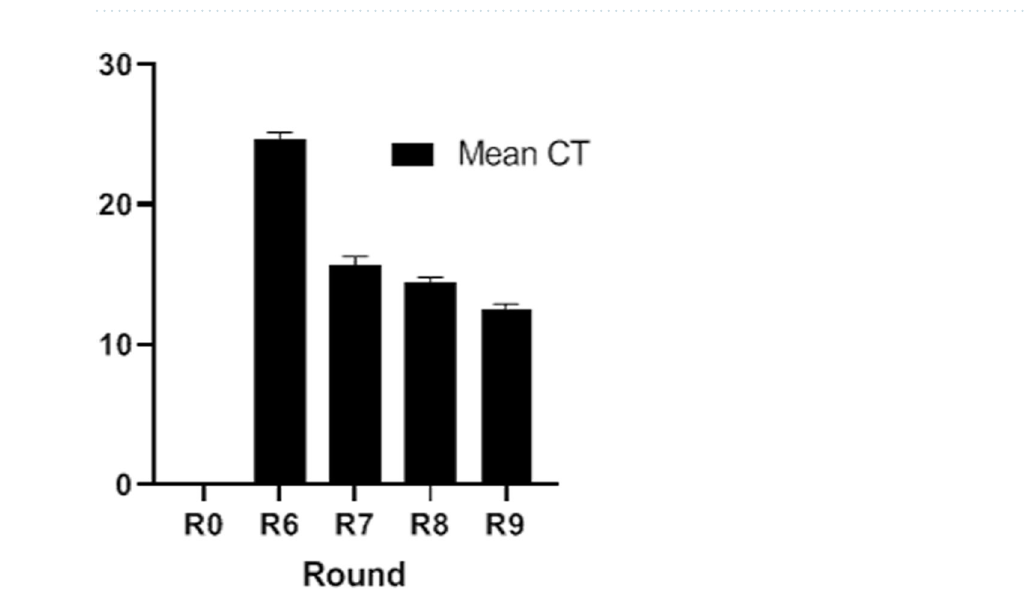
Figure 1. Schematic display of SELEX steps. ( A ) Schematic display of the preparation CCHFV NP-MB. The C-terminal of viral recombinant NP was biotinylated by the BirA enzyme and was fixed onto the surface of the streptavidin-coated magnetic beads. ( B ) ssDNA aptamers were mixed with Target; probable combinations of magnetic particles-NP-Aptamers (MB-NP-Apt) were deposited with a magnet. The attached aptamers were separated by heat giving after the sedimentation. The ssDNA bounded aptamers were amplified by PCR and were single-stranded by lambda exonuclease enzyme and entered the next round of SELEX. The PCR product of the optimum round was cloned and sequenced.